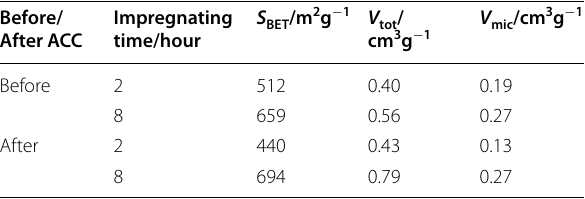
PO solution 3 4